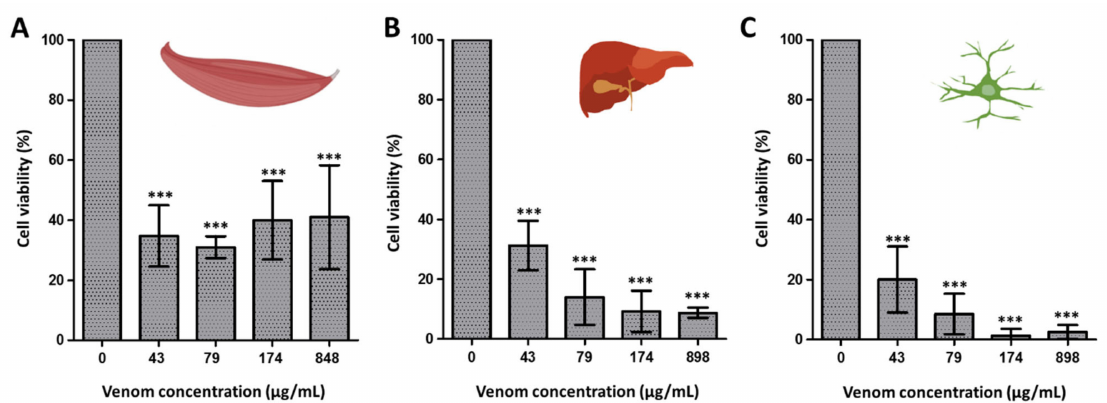
Figure 3. Cytotoxic effect of assassin bug venom. The effect of Rhynocoris iracundus venom was tested at different concentrations on healthy mouse myoblast cells C2C12 ( A ), on mouse hepatoma cells Hepa 1–6 ( B ), and on mouse neuroblastoma cells Neuro 2a ( C ). Shown are means and standard deviation values of the replicate samples. Statistical analysis was performed by one-way ANOVA with Tukey’s multiple comparison test applied for individual comparisons. Statistical significance of the differences of all venom concentrations against the control (0 µ g/mL) are indicated with asterisks (*** p < 0.0001).